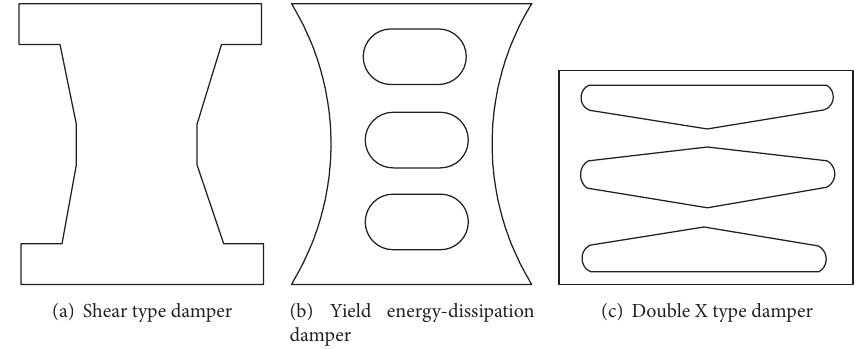
Figure 6: The hollow form of steel